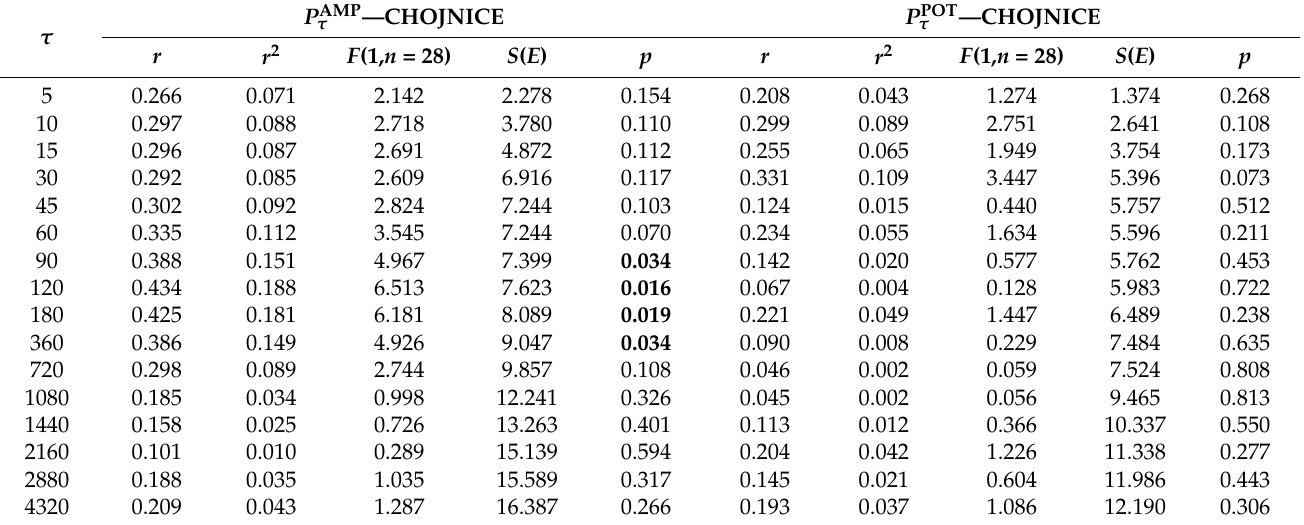
Table 5. Results of simple regression analysis for the Chojnice station, where the dependent variables are P AMP τ and P POT τ , and the independent variable is time ( τ ), for n = 30, where r is Pearson’s correlation coefficient; r 2 is the coefficient of determination; F (1, n ) is the Fisher-Snedecor test; S ( E ) is the standard error of estimation; and p ( p -value) is the value of the test probability. Bold type indicates significance of regression parameters, namely the existence (for p ≤ 0.05) of a significant linear trend coefficient.